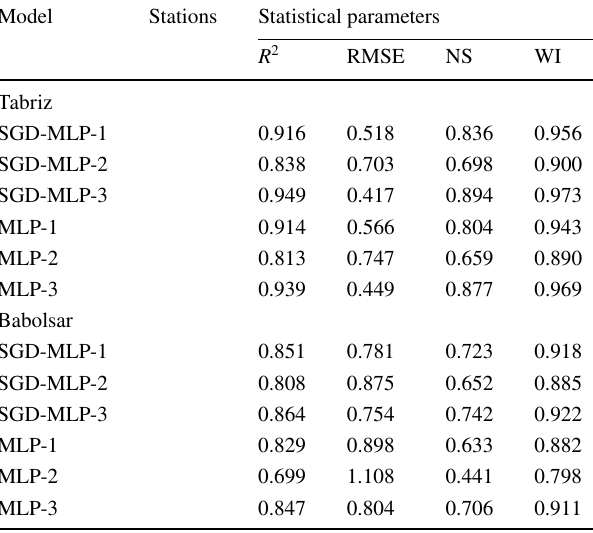
Table 5 Statistical values obtained during tests conducted at climate Tabriz and Babolsar with two different models using different input scenarios Model